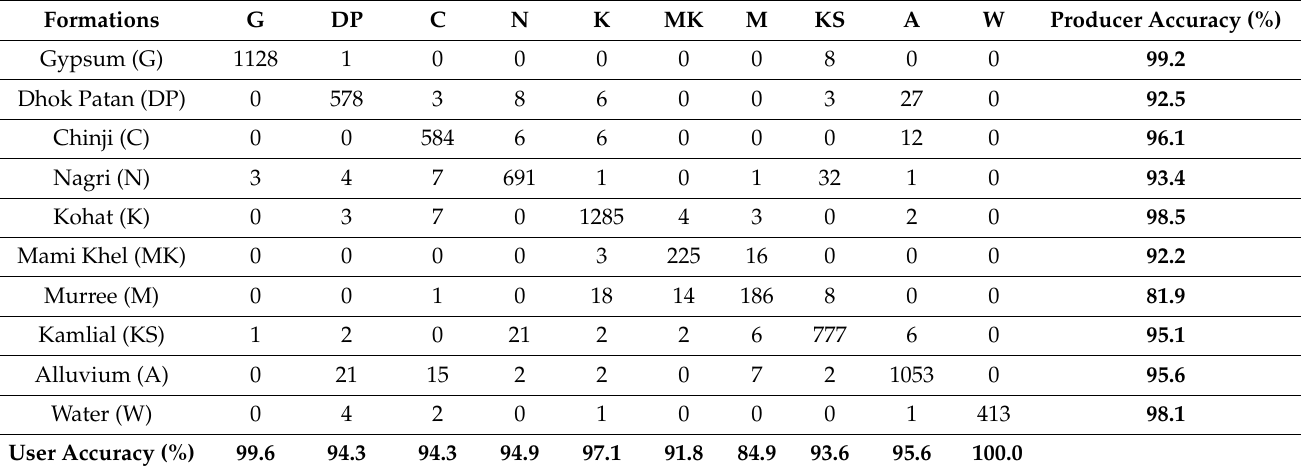
Table 5. Confusion matrix of support vector machine